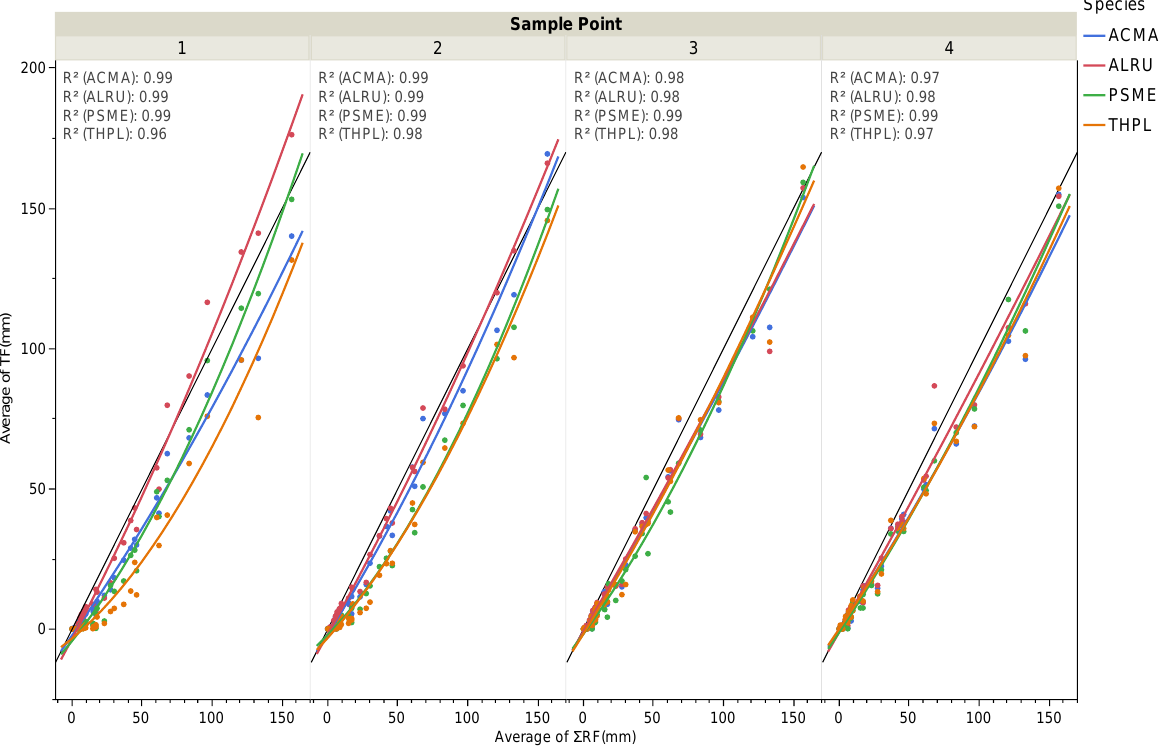
Figure 3. Simple linear regression relationships between precipitation ( Σ RF) and throughfall (TF) averaged by species for each collection period and catchment sample point throughout the study. Sample point 1: represents locations adjacent to tree bases. Sample point 2: represents locations ~40% away from the tree base. Sample point 3: represents locations ~70% from the base. Sample point 4 : at the canopy edge. In all panels, the colored lines reflect the different species, while the black line represents a 1:1 line. Species codons in the legend refer to A. macrophyllum (ACMA), A. rubra (ALRU), P. menziesii (PSME), and T. plicata (THPL). Deviations of slopes among species and curvilinear (polynomial) fits are more apparent for collections at the base of trees, while more linear relationships are common at distances greater than 40% of the canopy width.